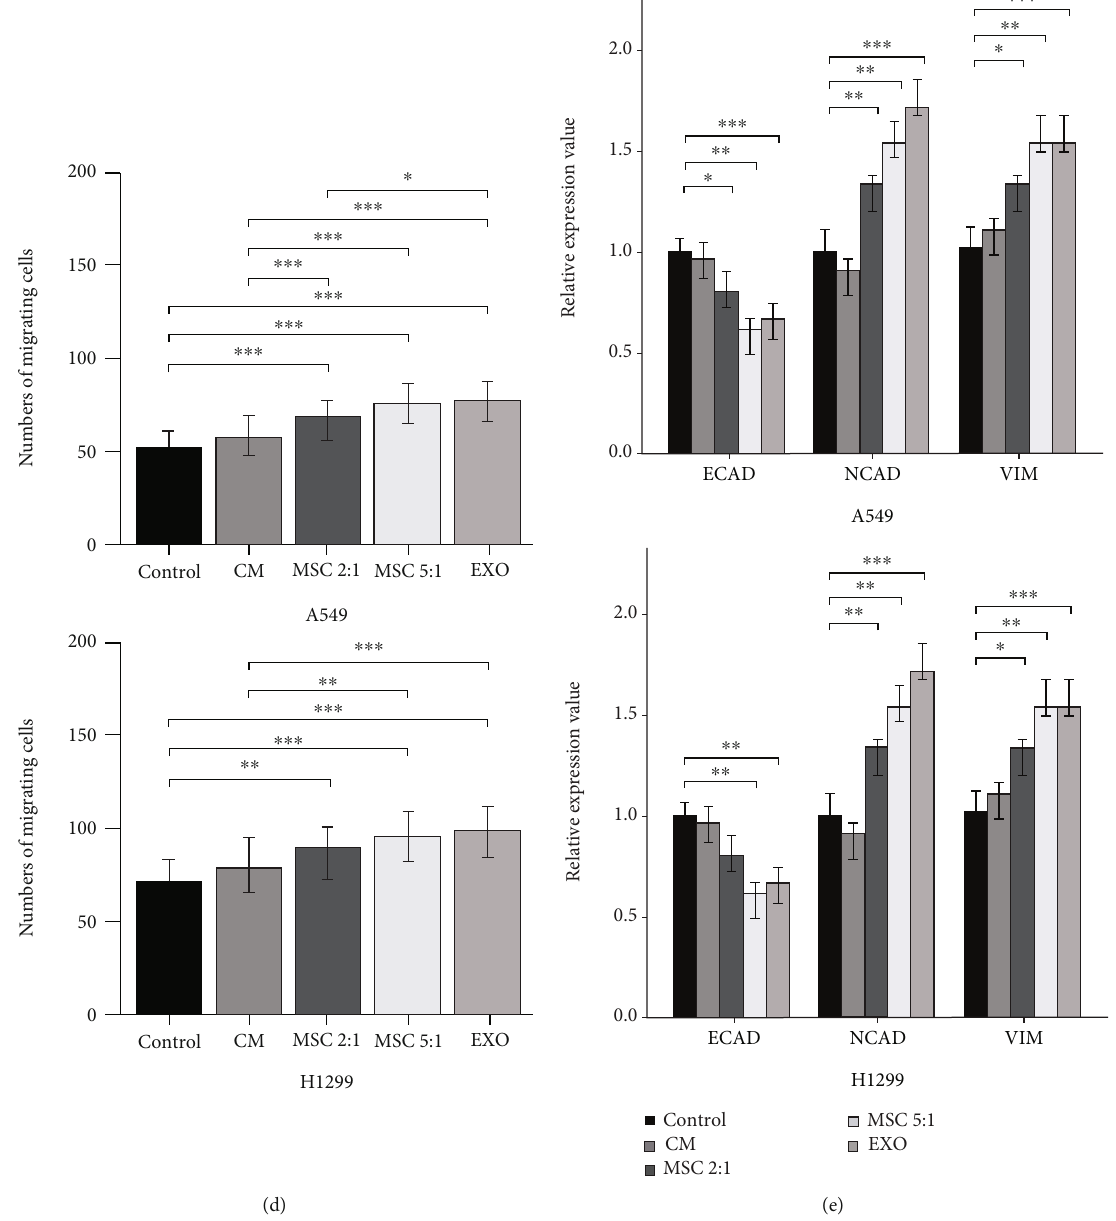
Figure 4: MSCs and MSC-exosomes promote migration and epithelial-mesenchymal transformation in the polyploid A549 and H1299 cells. (a, b) The CFSE proliferation analysis of the polyploid A549 and H1299 cells following coculture with MSC-CM, MSCs, and MSC- exosomes was examined by fl ow cytometry at 0 hour, 48 hours, and 72 hours. (c, d) The quantitative analysis of migration ability of the polyploid A549 and H1299 cells following coculture with MSC-CM, MSCs, and MSC-exosomes was examined by transwell assay at 48 hours. (e) The expressions of ECAD, NCAD, and VIM in the polyploid A549 and H1299 cells following c-culture with MSC-CM, MSCs, and MSC-exosomes were detected by RT-qPCR analysis at 48